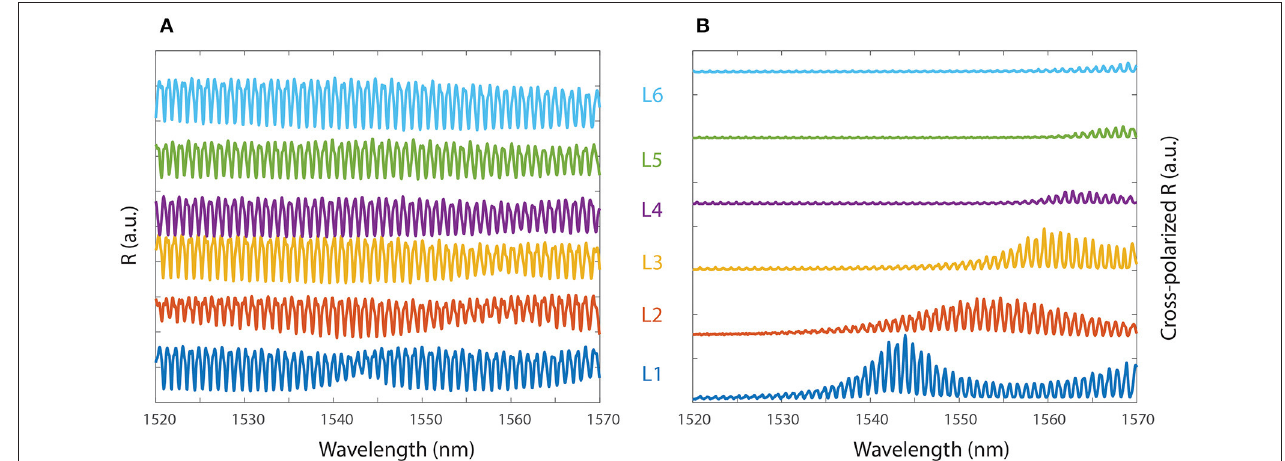
FIGURE 4 | Direct (A) and Cross-polarized (B) reflectivity spectra for different metasurfaces.